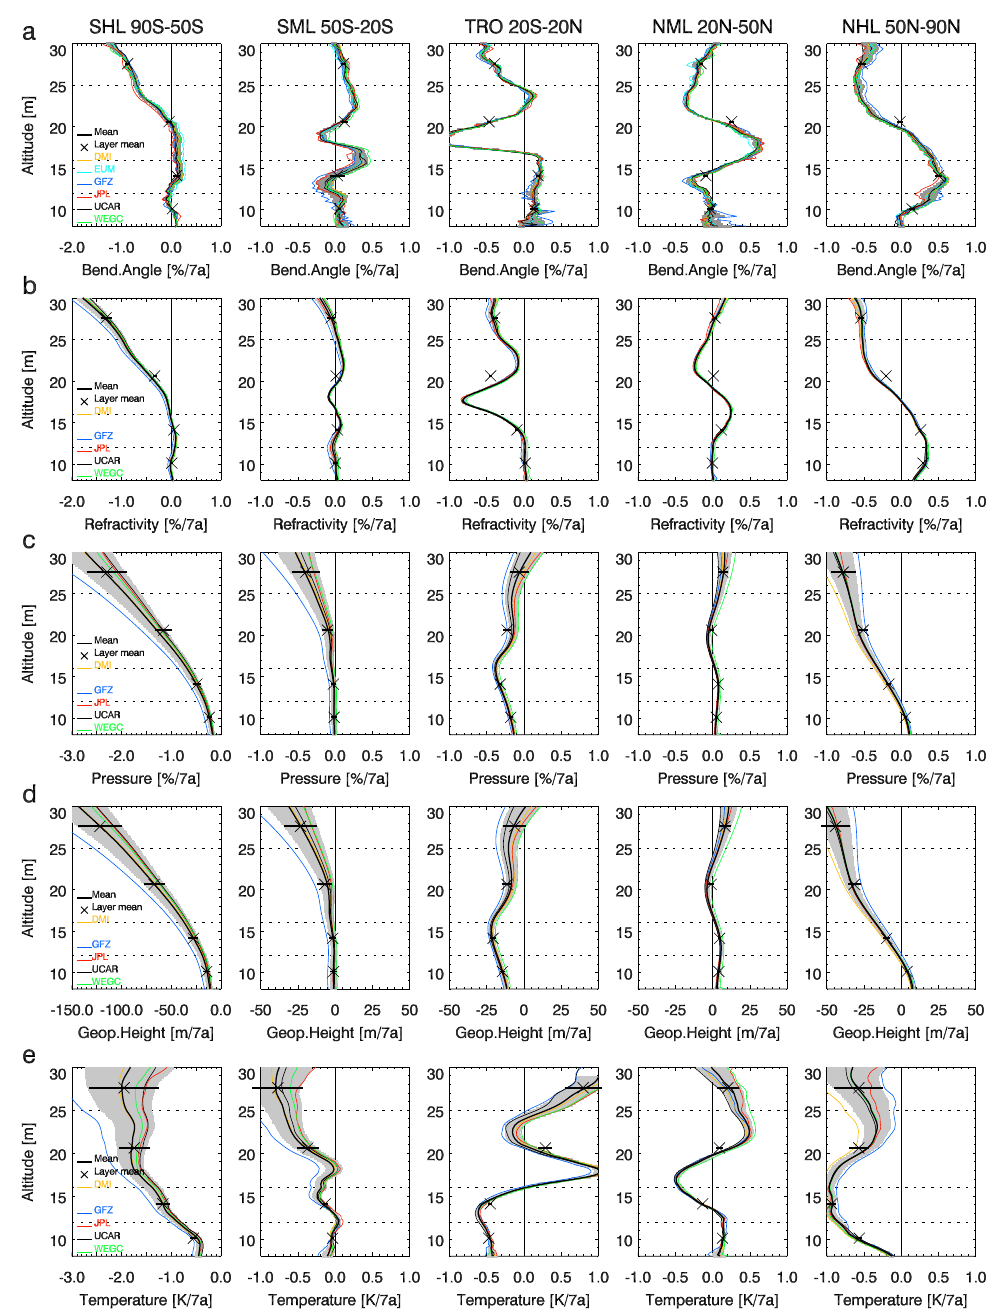
Fig. 4. Temperature trend (black line) and standard deviation (gray) of the all-center mean for the CHAMP period September 2001 to September 2008 shown for (a) bending angle, (b) refractivity, (c) pressure, (d) geopotential height, and (e) temperature for (left to right) five zonal regions. Layer mean values are indicated (crosses). Individual center trends are shown for DMI (yellow), GFZ (blue), JPL (red), UCAR (black), WEGC (green). Note the different x-axis for the SHL